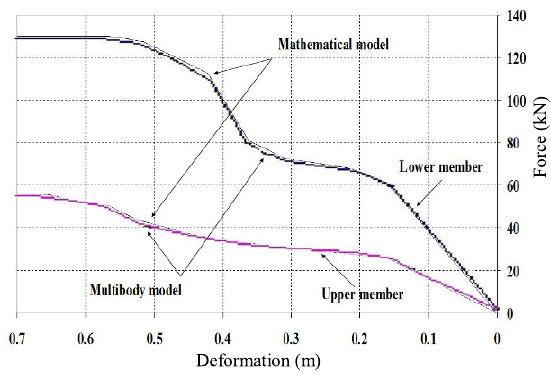
Figure 6. Force deformation characteristics for upper and lower rails.